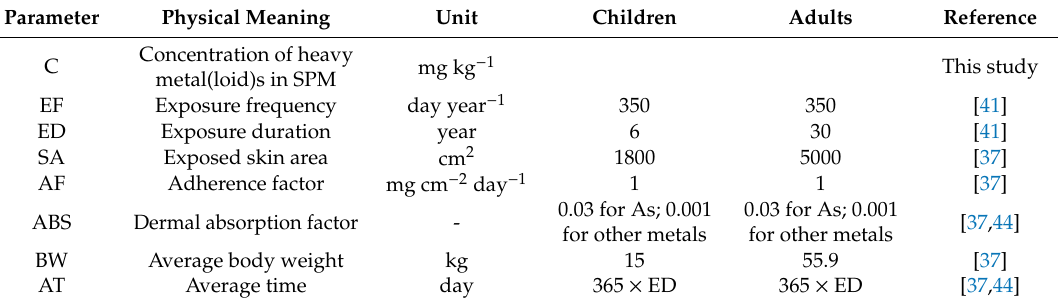
Table 2. Values and factors used for non-carcinogenic hazard health risk